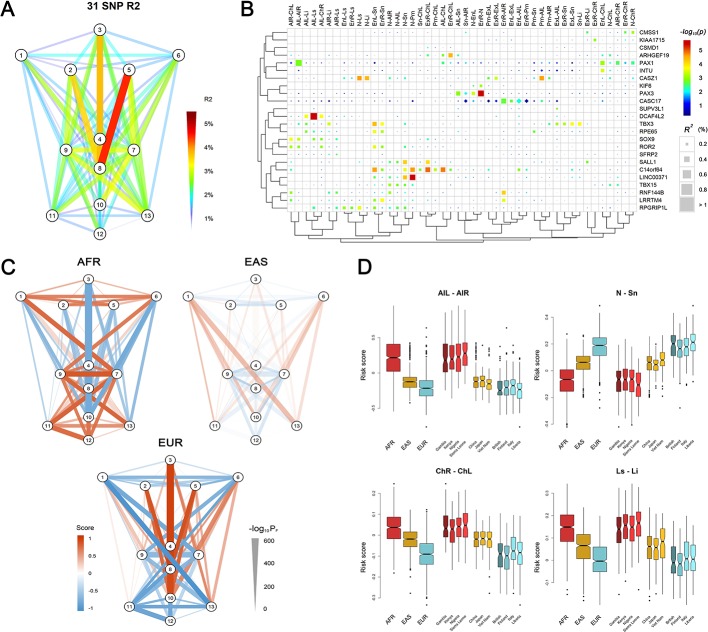
Polygenic scores of 78 facial phenotypes.(A) Facial phenotype variance is explained by a multivariable model consisting of 31 face-associated SNPs with independent effects. (B) Unsupervised clustering reveals the details on the explained phenotype variance, where the SNPs were attributed to the candidate genes in the associated regions. All phenotypes with the total explained variance > 2% are shown. SNPs were colored according to their raw p-values and those passing FDR < 0.05 were indicated in squares. (C) Mean standardized polygenic scores calculated by applying the multivariable model trained in the RS discovery sample to Sub-Saharan Africans (AFR), East Asians (EAS) and Europeans (EUR) in the 1000 Genomes Project data. (D) Examples of the distributions of the face scores in samples of different ancestry origin/country.